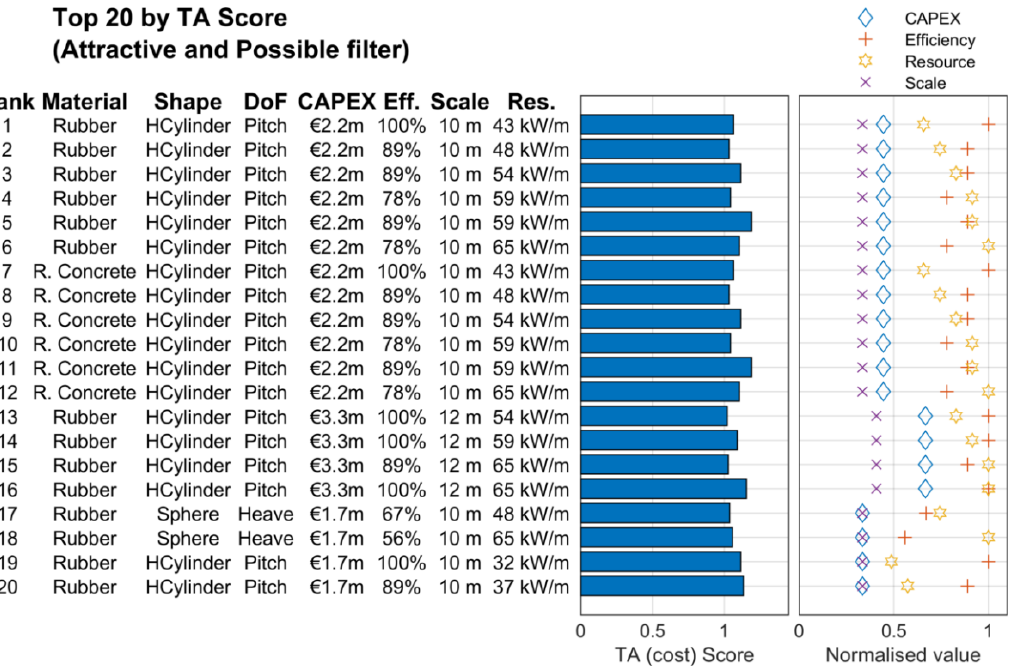
Figure 10. Graphical representation of the results with zoomed in scale (10–30 m) showing the what-if range parameters as columns of the top 20 most attractive (but not achievable) scenarios ranked by TA score. Normalised values of the what-if range parameters can be seen on the right.